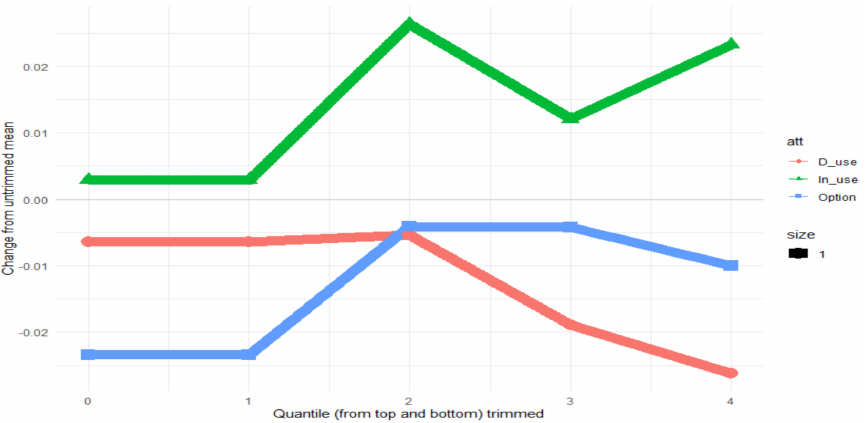
Figure 7. Changes of aggregated weights based on quantile of data trimmed (use